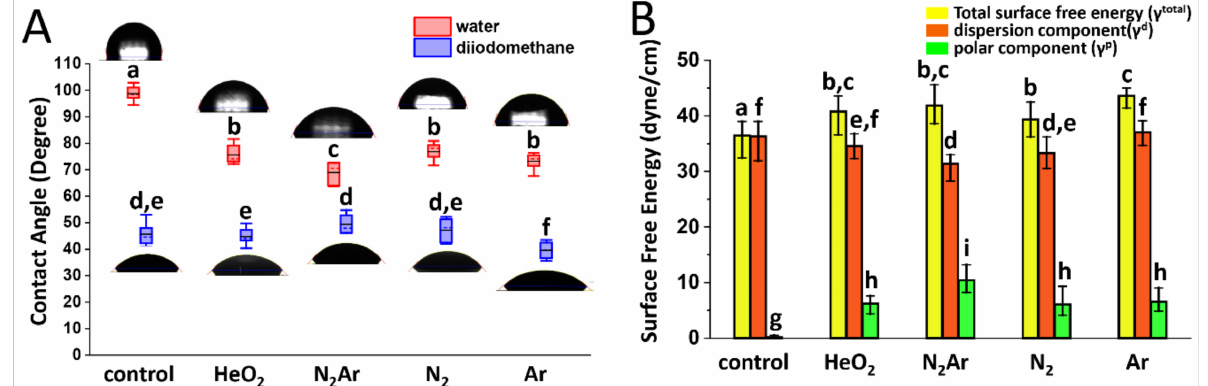
Figure 1. ( A ) Contact angles of water and diiodomethane; box plot showing the mean (black solid horizontal line), median (dashed horizontal line), interquartile range (box), and total range (whiskers) of the data set. ( B ) Values of the total surface free energy ( γ total ), dispersion component ( γ d ), and polar component ( γ p ) in the zirconia specimens subjected to each plasma treatment. An identical letter within each value indicates no significant difference between each type of plasma gas ( p > 0.05). The error bar represents the standard deviation. Table 1. Contact angles for water and diiodomethane on the zirconia surfaces of each plasma group. Contact Angle ( ◦ Plasma Group